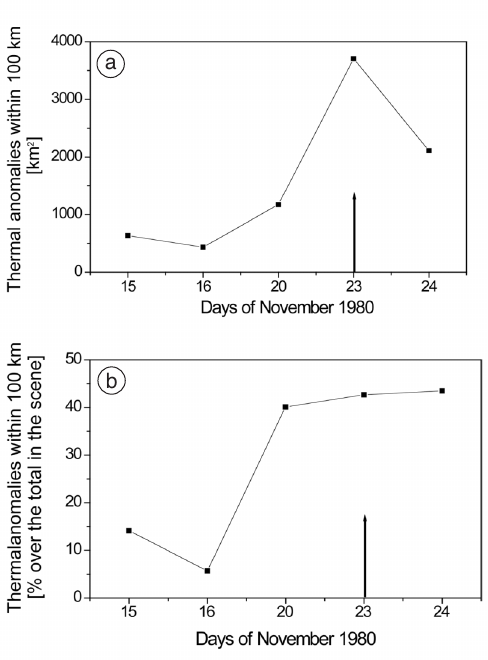
Fig. 4a,b. Irpinia-Basilicata earthquake ( M S = 6.9, November, 23, 1980, 7.32 p.m.): a) temporal evolu- tion of the extension of the thermally anomalous area around the epicenter. The extension of thermal anomalies (expressed in AVHRR pixel number) oc- curring in a circle of 100 km of radius around the epicenter, is plotted few days before and after the earthquake occurrence (black arrow). Modified from Tramutoli et al. (2001). b) Comparative analysis of the temporal evolution of the extension of thermal anomalies within and far away from the epicentral zone. The percentage (over the total in the scene) of thermal anomalies falling in a circle of 100 km of ra- dius around the epicenter, is plotted few days before and after the earthquake occurrence (black arrow). Modified from Tramutoli et al.